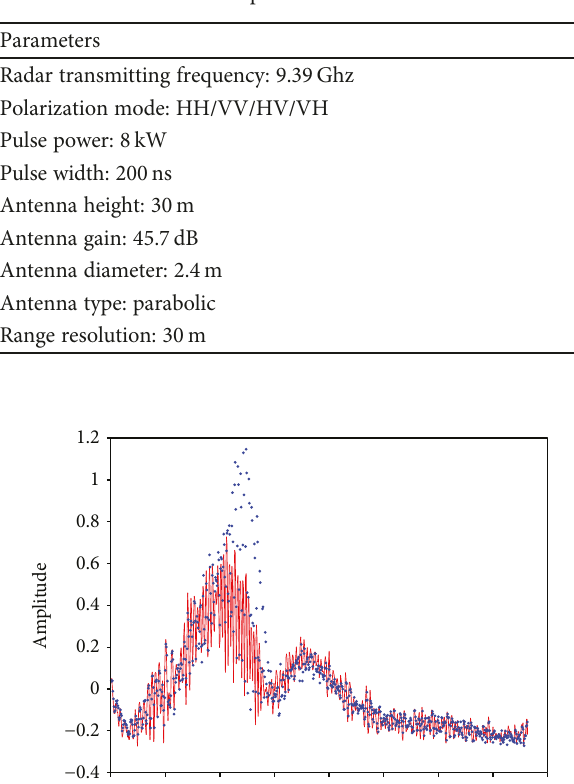
Table 1: Main parameters of IPIX radar.